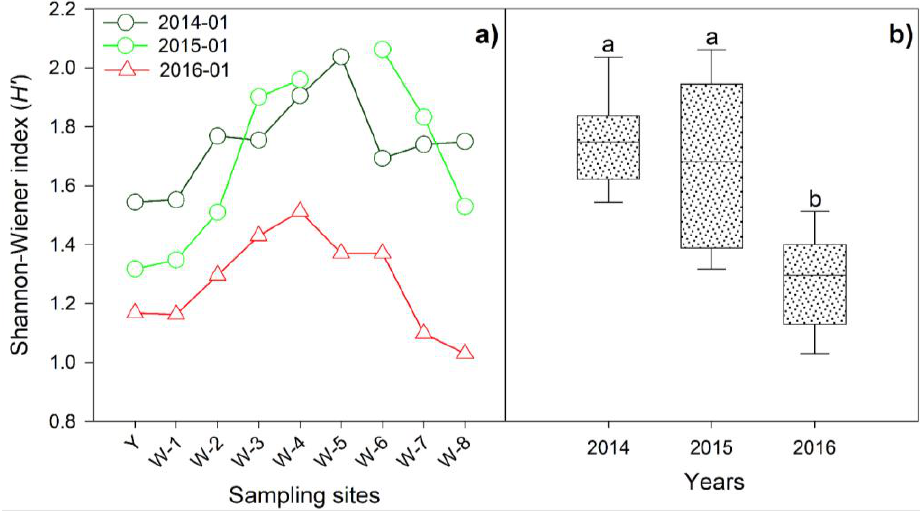
Figure 3. The spatial variations ( a ) and differences ( b ) of phytoplankton diversities in the Wangyu River channel. The different letters represent a significant difference.